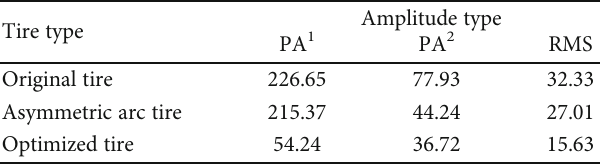
Table 6: The comparison of